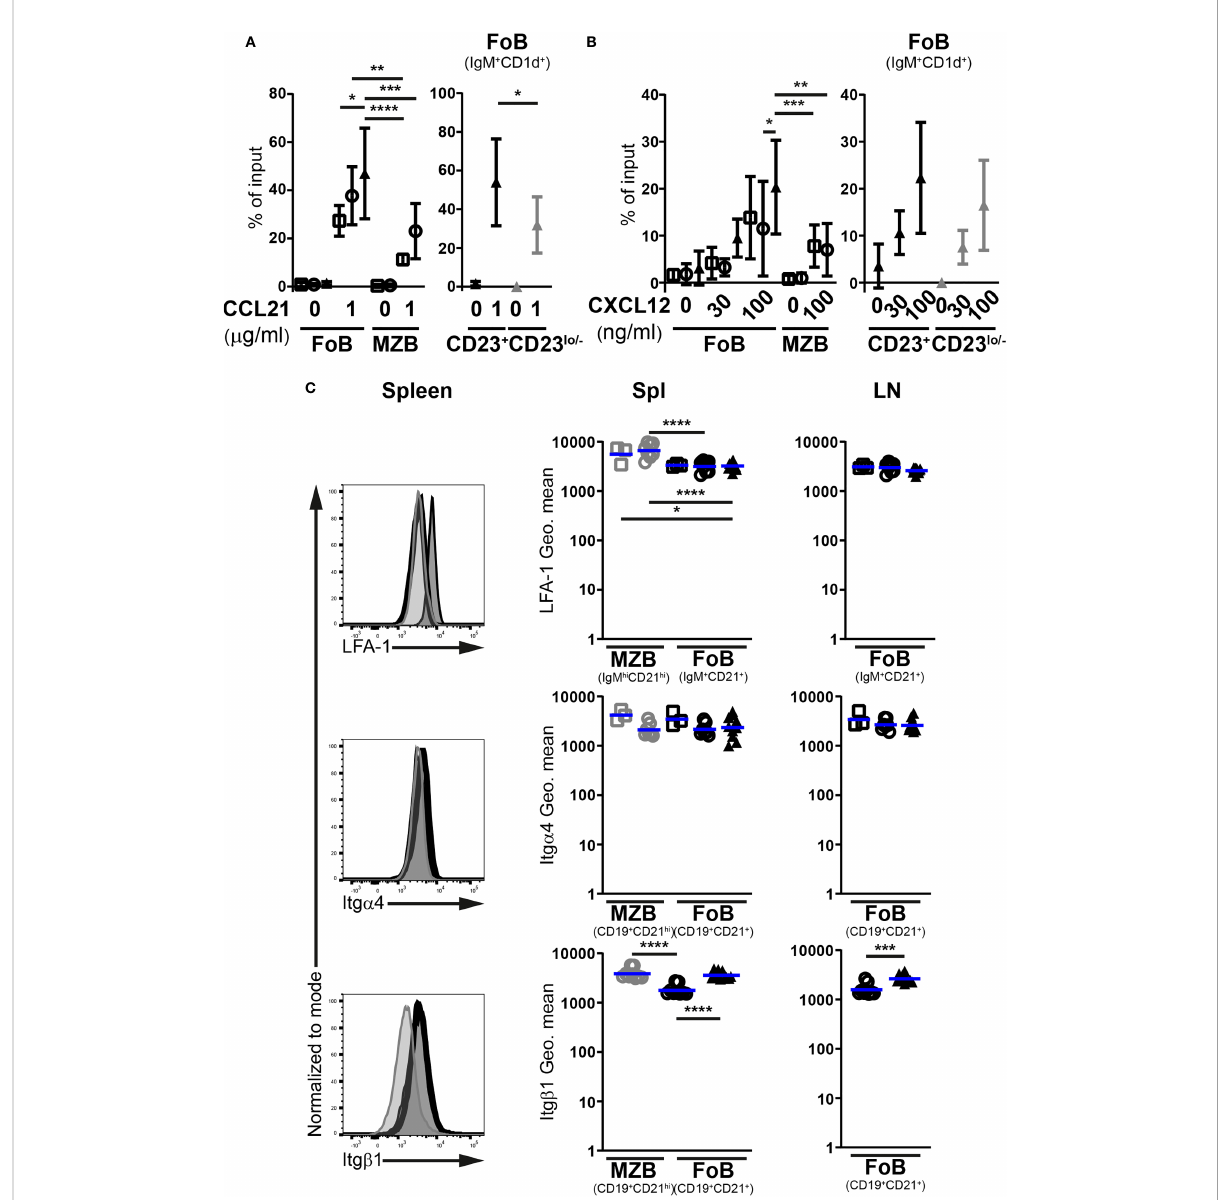
FIGURE 4 miR-142-de fi cient follicular B cells do not show signs of compromised ability to fi rmly adhere to high endothelial venules. In vitro migration of splenic IgM + CD1d + follicular (FoB) and IgM hi CD1d hi marginal zone (MZB) CD19 + B220 + CD93 – mature B cells, as well as CD23 + and CD23 lo/ – mutant Fo B cells from Mb1-cre – ( □ ), Mb1-cre + ( ○ ) and Mb1-cre + miR-142 fl ( ▲ ) mice in response to (A) 1 m g/ml CCL21 ( n = 4-7 per group in 9 independent experiments) as well as (B) 30 and 100 ng/ml CXCL12 ( n = 5-12 per group, cumulative of 14 independent experiments). B cells were identi fi ed by fl ow cytometry. Cells that migrated to the bottom chamber of the transwell after 3h are given as proportions of the speci fi c B population in the input splenocytes (% of input). (C) Left: fl ow cytometry of the expression of LFA-1, integrin a 4 (Itg a 4) and integrin b 1 (Itg b 1) at the surface of splenic IgM + CD21 + or CD19 + CD21 + Fo B cells (thick black histogram) from Mb1-cre + miR-142 fl mice, as well as on splenic IgM + CD21 + or CD19 + CD21 + Fo (light grey- fi lled histogram) and IgM hi CD21 hi or CD19 + CD21 hi MZ (dark grey- fi lled histogram) B cells from Mb1-cre + control animals. Right: Geometric means (Geo. mean) of surface LFA-1, Itg a 4 and Itg b 1 on Fo (black) and MZ (grey) B cells from spleens (Spl) and lymph nodes (LN) of Mb1-cre – ( □ ), Mb1-cre + ( ○ ) and Mb1-cre + miR-142 fl ( ▲ ) mice. n = 3-11 per group in 6-7 independent experiments. (A, B) Symbols and vertical lines indicate the means and standard deviations respectively. (C) Each symbol represents one mouse. Horizontal blue lines signify the means. *, P ≤ 0.05; **, P ≤ 0.01; ***, P ≤ 0.001; ****, P ≤ 0.0001 by one-way ANOVA (A – C) or Student ’ s t test (C) . (A, B) Data on Fo B cell migration in absence of treatment from 4 Mb1-cre – , 6 Mb1-cre + and 7 Mb1-cre + miR-142 fl mice are shared between the 2 graphs. (B) Samples excluded from the analysis: One mutant Fo B cells (100 ng/ml CXCL12) for an aberrant high value. One Mb1-cre – and 3 Mb1-cre + MZ B cells (100 ng/ml CXCL12) for insuf fi cient events in the